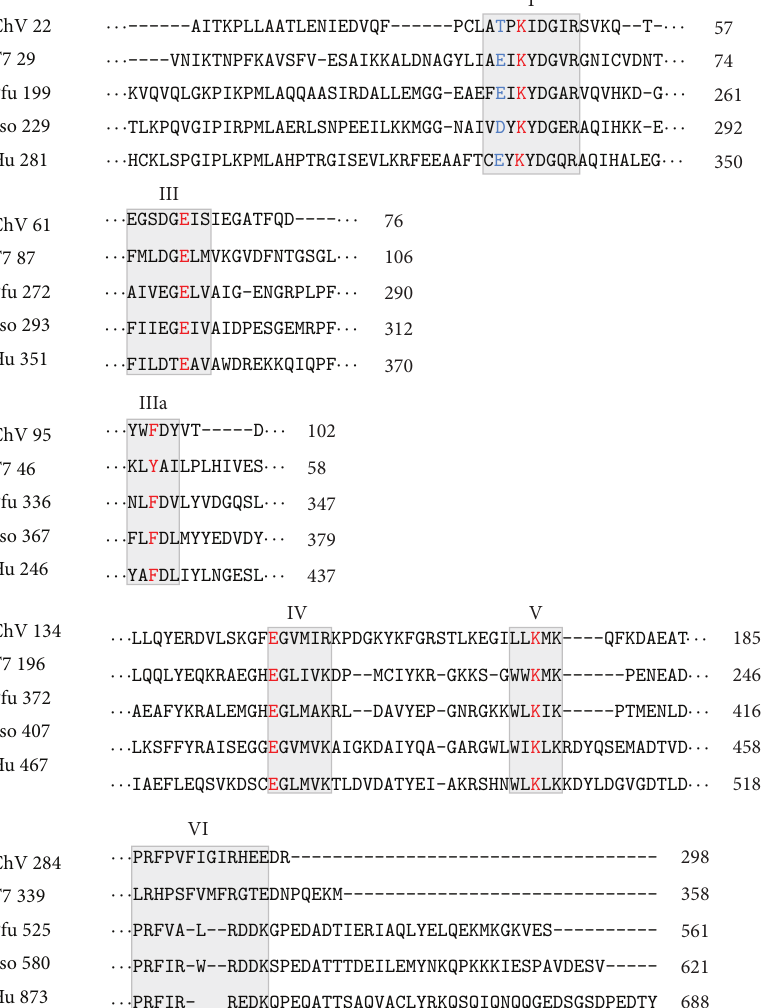
REDKQPEQATTSAQVACLYRKQSQIQNQQGEDSGSDPEDTY Figure 2: Conserved sequence elements define a superfamily of covalent nucleotidyltransferases. Six collinear sequence elements, designated as motifs I, III, IIIa, IV, V, and VI, are conserved in capping enzymes and ligases. The amino acid sequences are aligned for the DNA ligases from Chlorella virus (ChV), bacteriophage T7 (T7), Pyrococcus furiosus (Pfu), Sulfolobus solfataricus (Sso), and human (Hu). The number of intervening amino acid residues is indicated. Conserved residues are highlighted in red (nucleotidyltransferases) and blue (DNA and RNA